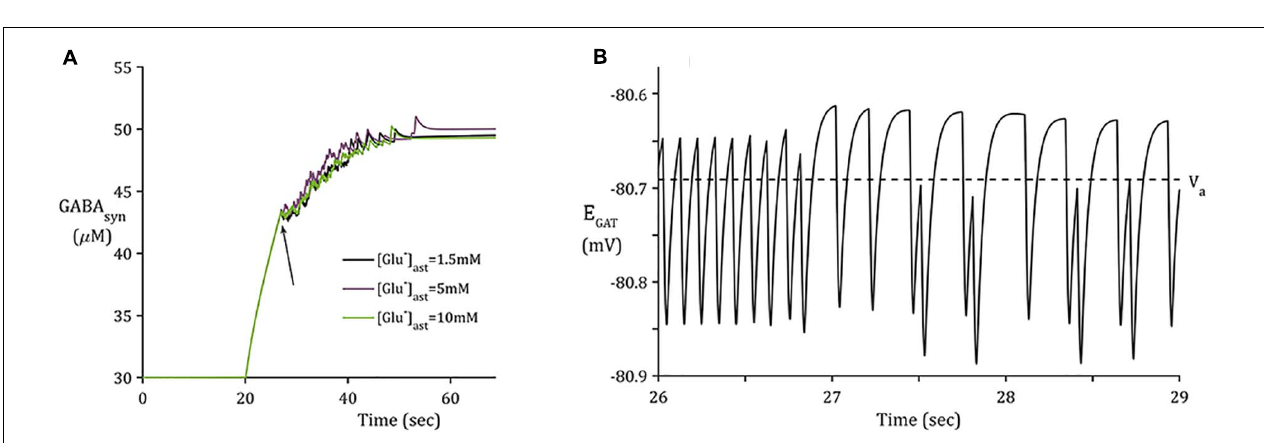
FIGURE 4 | Synaptic GABA dynamics: (A) GABA concentration due to GAT-3 activity (B) 3-s window of GAT-3 reversal potential for [Glu] ast = 1.5 mM (initial time of window indicated by arrow in panel (A).